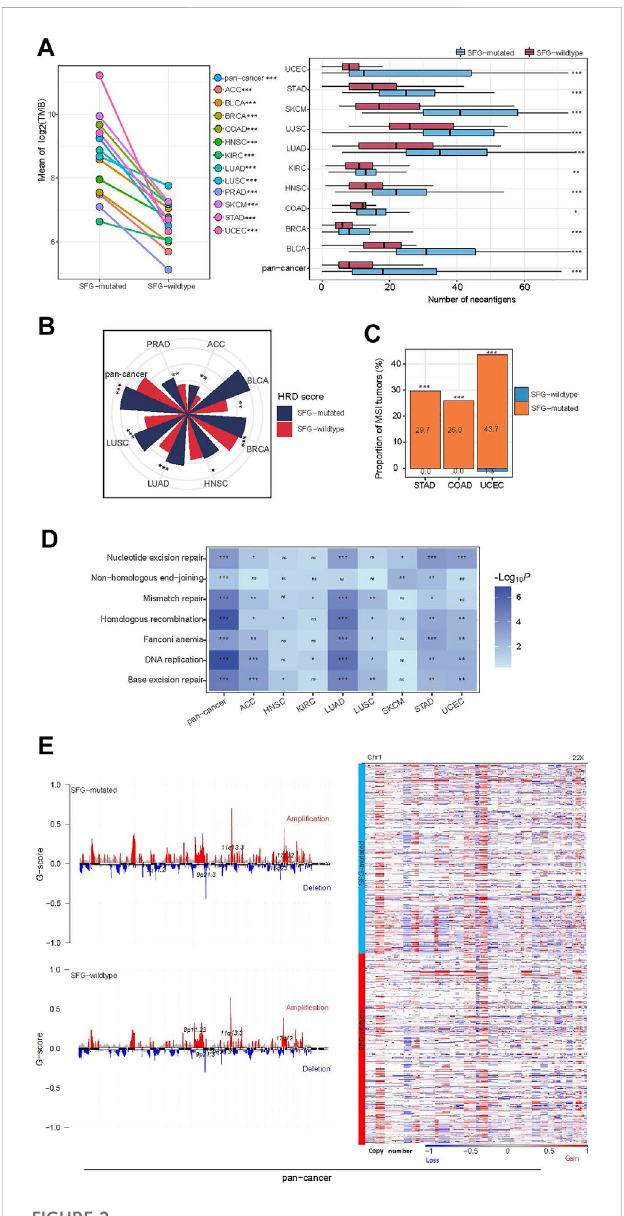
FIGURE 2 SFG mutations correlate with genomic instability in cancer.